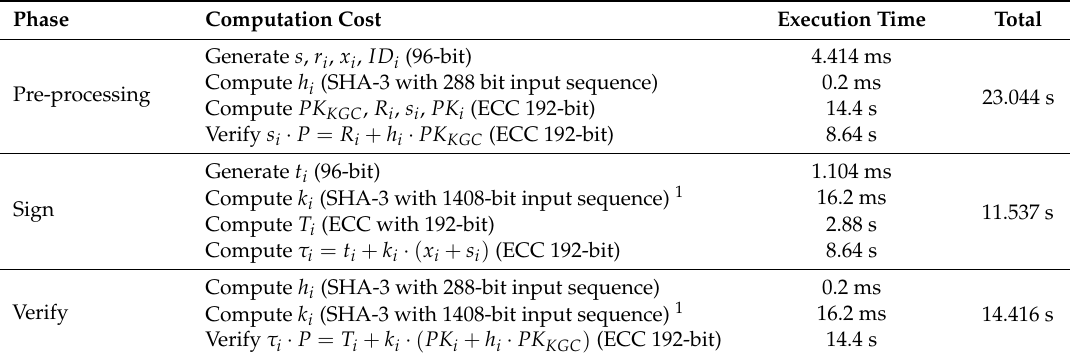
Table 2. The computation cost of our proposed certificateless signature scheme implemented on the Arduino Uno with Condition (1).